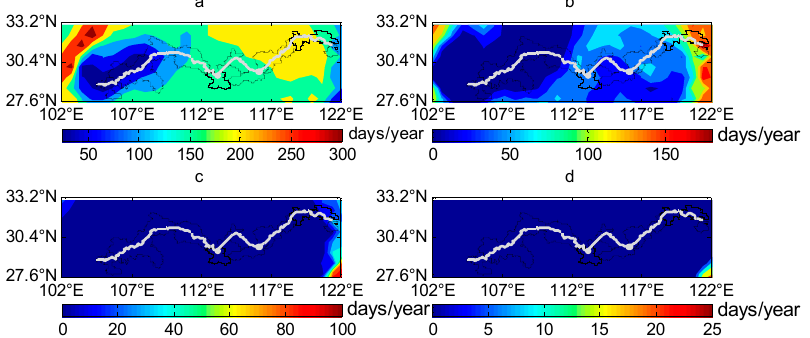
Figure 8. Number of days with the wind gust (( a ) slight risk, ( b ) middle risk, ( c ) high risk, and ( d ) extreme risk) during the period 1979–2017 based on ERA-Interim Reanalysis data.